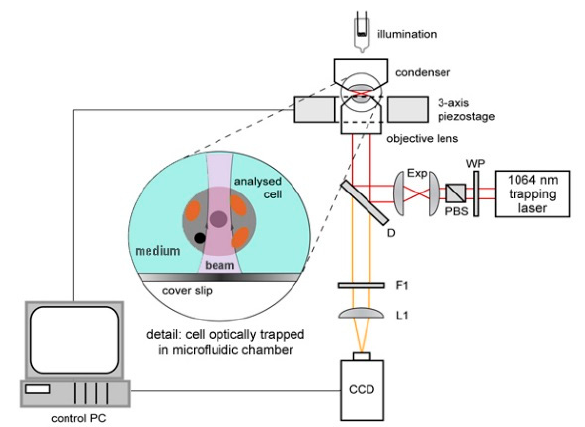
Figure 1. Experimental setup for optical trapping and video microscopy of Saccharomyces cerevisiae cells. WP: half-wave-plate; PBS: polarizing beam splitter; Exp: expander; D: dichroic mirror; CCD: CCD camera; F1: edge filter; L1: focusing lens. For detailed parameters of the system components, see the main text.